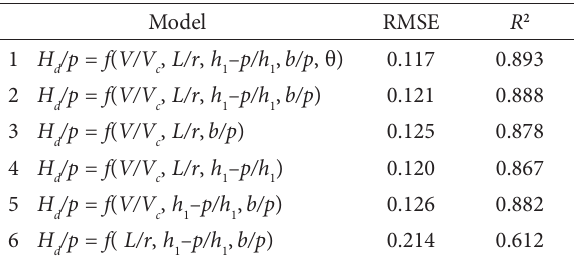
Table 4. Sensitivity analysis for independent parameters for the testing set